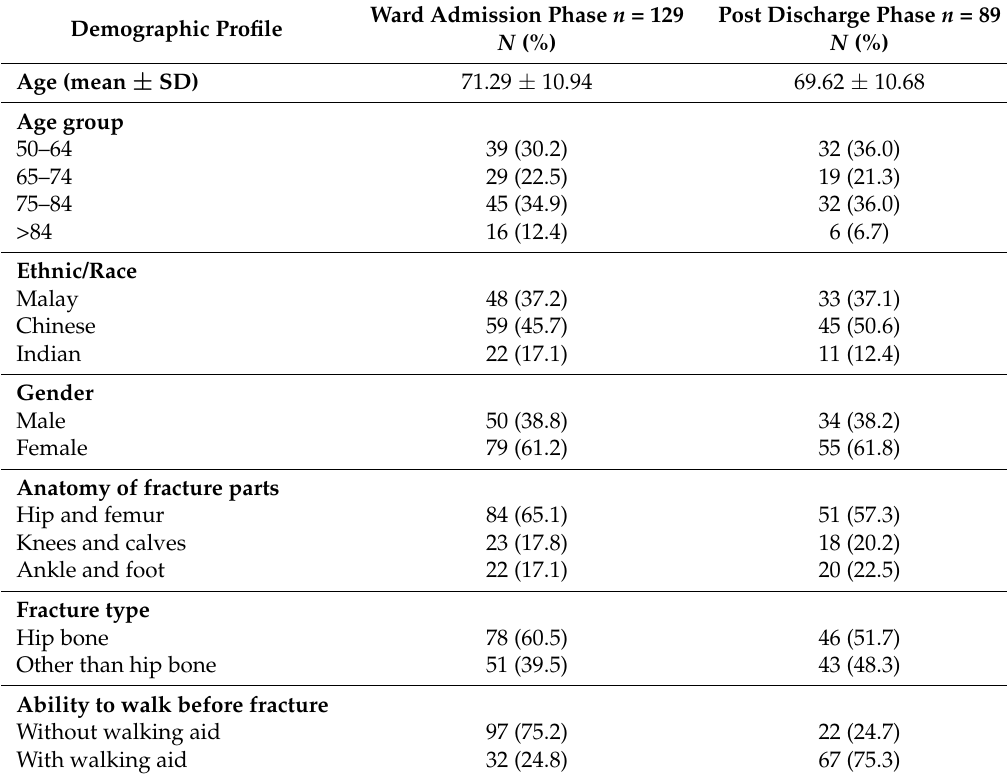
Table 1. The demographic data of the patients recruited in this study.